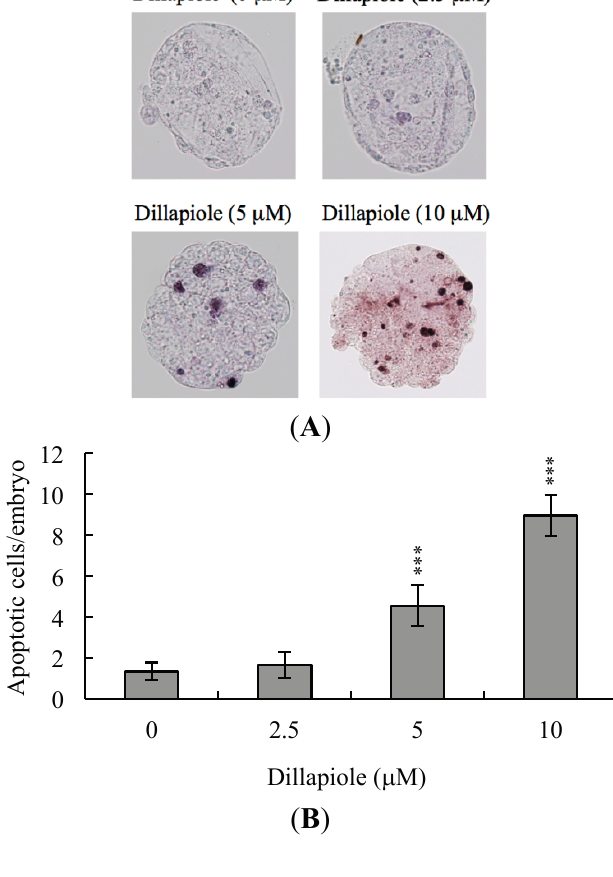
Figure 1. Dillapiole induces apoptosis in mouse blastocysts. ( A ) Mouse blastocysts were treated with dillapiole (2.5, 5, or 10 μ M) for 24 h or left untreated, and apoptosis examined via TUNEL staining. Cells were visualized using light microscopy. TUNEL-positive cells are depicted in black; ( B ) The mean number of apoptotic (TUNEL-positive) cells per blastocyst was calculated. Data are based on at least 180 blastocyst samples from each group and presented as means ± SEM of six determinations. *** p < 0.001 versus the control